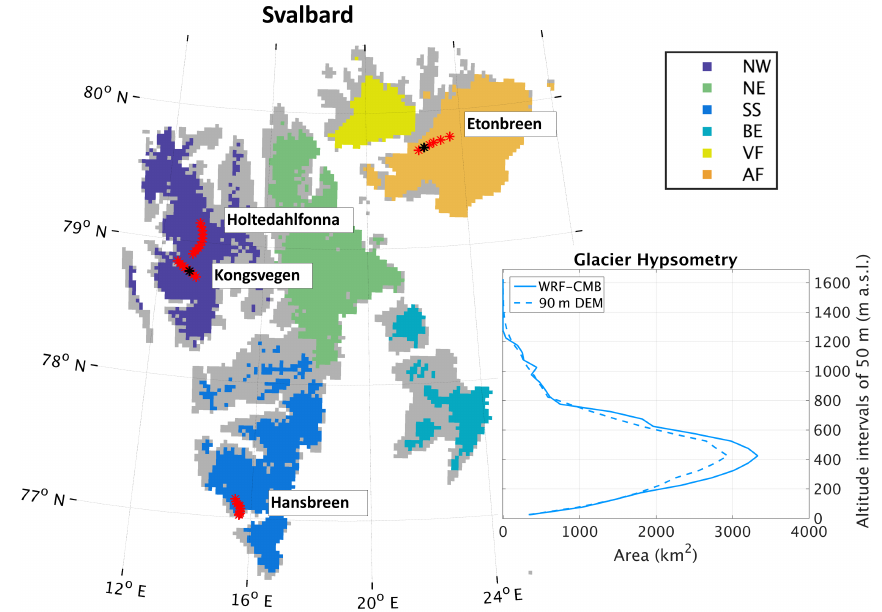
Figure 1. Main figure: land areas in the 3km model domain. Colors indicate glacier grid cells in different subregions and gray indicates non-glacier land grid cells. Stake and AWS locations at the four main validation glaciers are shown as red ∗ and black ∗ , respectively. NW: northwestern Spitsbergen; NE: northeastern Spitsbergen; SS: southern Spitsbergen; BE: Barentsøya and Edgeøya; VF: Vestfonna; AF: Austfonna. Overlay figure: glacier hypsometry from 3km model domain compared with 90m digital elevation model (Nuth et al.,